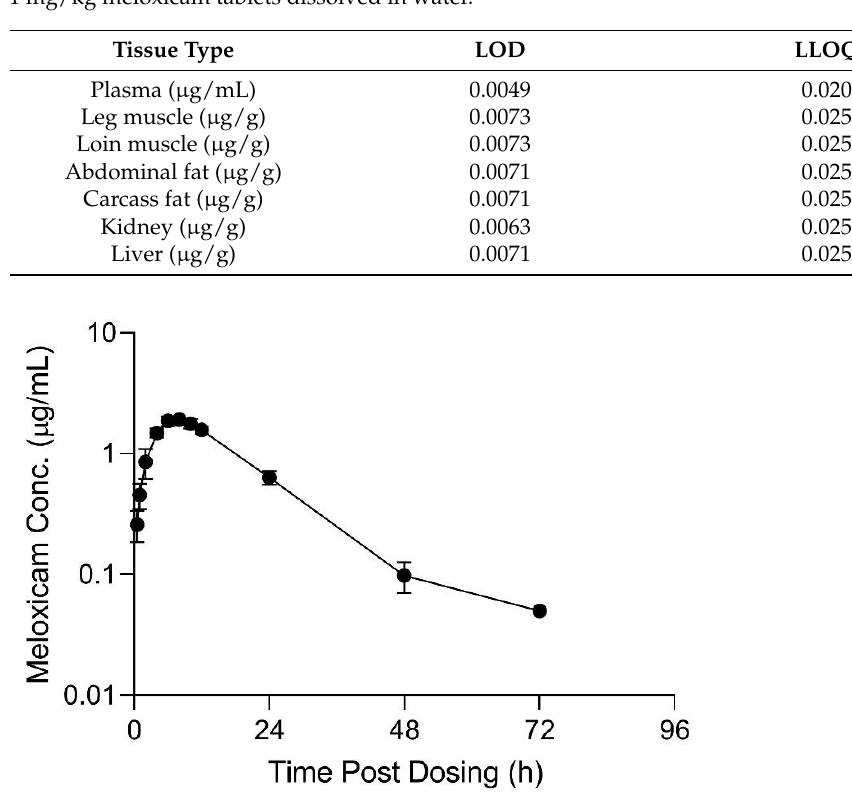
Figure 2. Mean plasma meloxicam concentrations (+SD) sampled over time (0 – 96 h) for six sheep administered a single oral 1 mg/kg dose of meloxicam tablets dissolved in water. Values below the lower limit of quantitation and limit of detection are excluded.